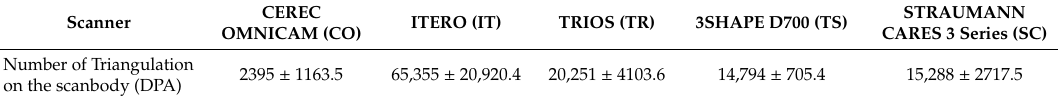
Figure 5. Surface topography on the top surface area of the scanbody. Figure 5 Surface topography on the top surface area of the scanbody. Table 2. Summary of the number of triangulation points on the scanbody. Table 2. Summary of the number of triangulation points on the scanbody.